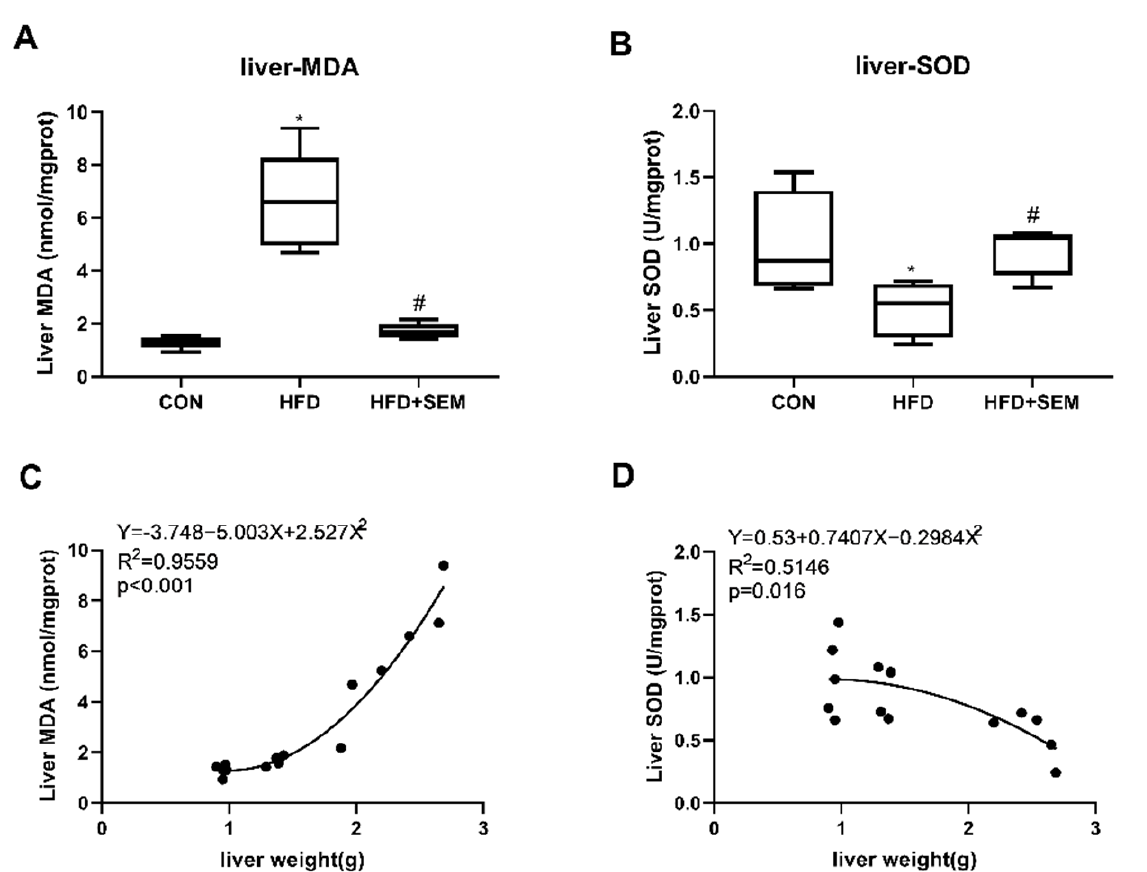
Figure 3. SEM treatment ameliorates oxidative stress in the liver of mice with hepatic steatosis caused by HFD. Effects of HFD and HFD + SEM on ( A ) MDA secretion in the liver, ( B ) SOD secretion in the liver, ( C ) correlation of hepatic MDA secretion with liver weight, and ( D ) correlation of hepatic SOD secretion with liver weight. Box-and-whisker diagrams are presented as min to max and were analyzed with one-way ANOVA; * vs. control group ( p ≤ 0.05); # vs. HFD-alone treatment group ( p ≤ 0.05). Correlation data ( C , D ) are fitted to a second-order polynomial. Equation, r 2 and p -value are shown in the left upper corner. Statistical analysis was performed by the Spearman’s rank correlation test; p ≤ 0.05 shows a statistically significant